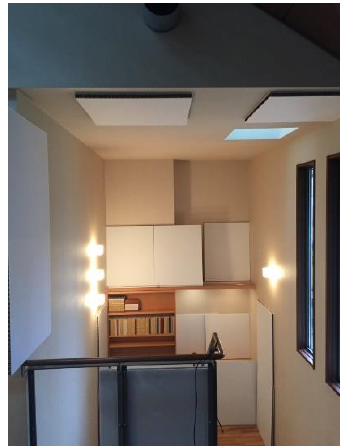
Figure 7. Sound absorption panel installation setup in the wall and ceiling of second floor.